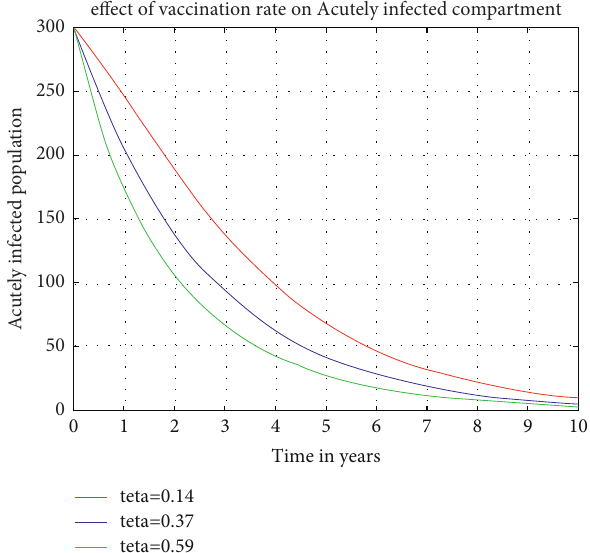
Figure 17: Effect of treatment rate on susceptible